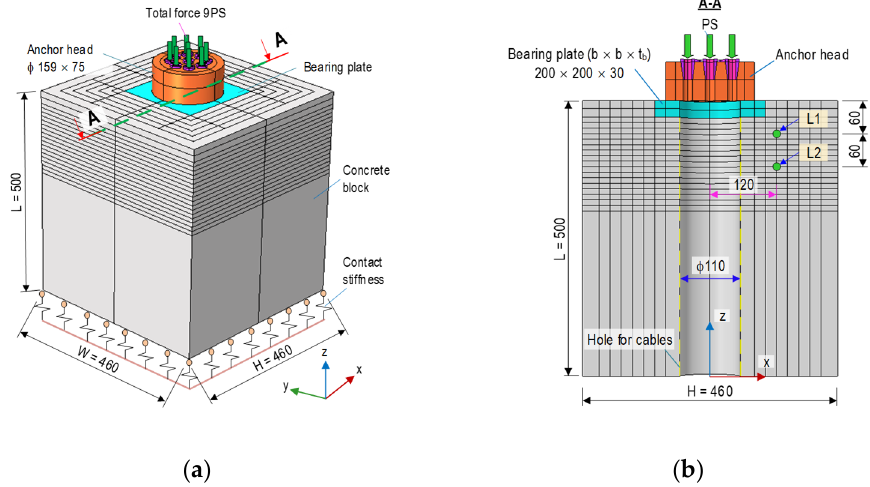
Figure 1. FE model of prestressed anchorage zone (dimension in mm): ( a ) 3D view of anchorage zone; ( b ) Cross-section A-A.